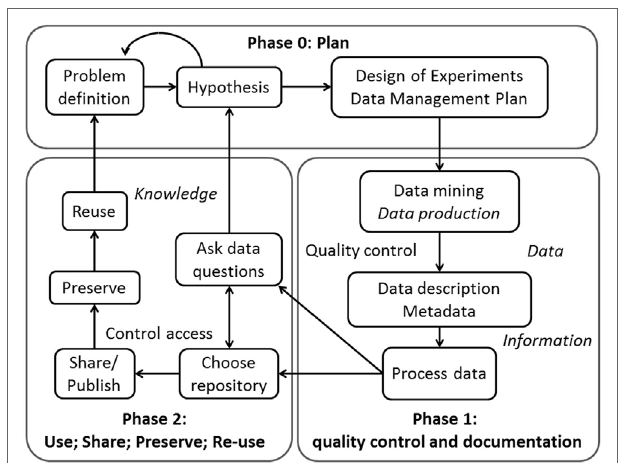
FiGURe 1 | The life cycle of scientific data. Phase 0 refers to the planning: from the problem definition, scientists will generate a hypothesis and will develop the proper design of experiments and a data management plan. Phase 1: scientists will search in data repositories and in literature for answers to their questions and, if this is not enough, will produce the specific data set. Then, they will use specific metadata to structure/describe the data. Thereafter, this structured data can be processed. Phase 2 refers to the (re-) use, share, preservation, and data reusability. After processing, the scientists will ask specific questions concerning the data and will analyze it accordingly. They can also choose a repository to store the data. Then, they can share and/or publish the data in order to preserve it and allow others to reuse it (or reuse it themselves in the future). This allows for multiple analyses of the same data